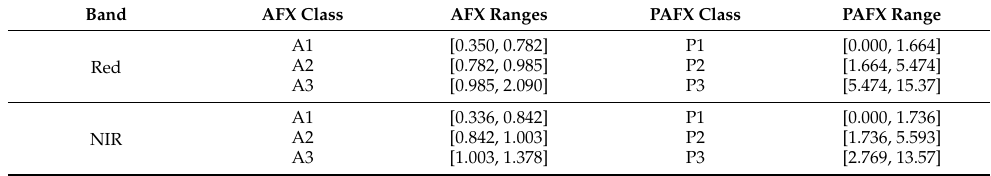
Table 1. Range of AFX and PAFX for different BRDF archetypes within a 3-by-3